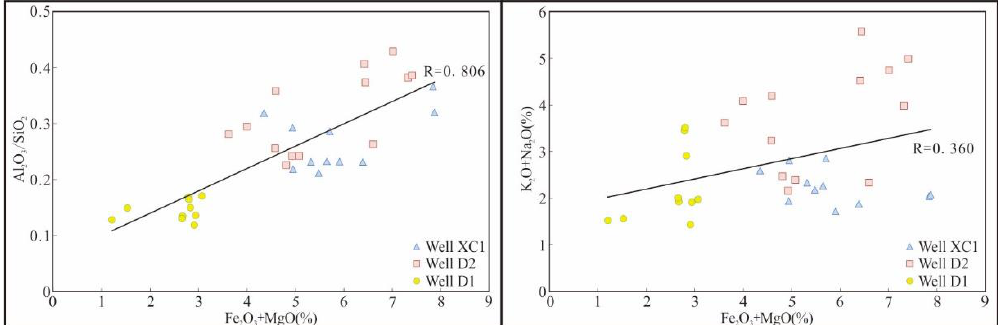
Figure 3. Plot of Al 2 O 3 /SiO 2 and K 2 O/Na 2 O to Fe 2 O 3 + MgO content.